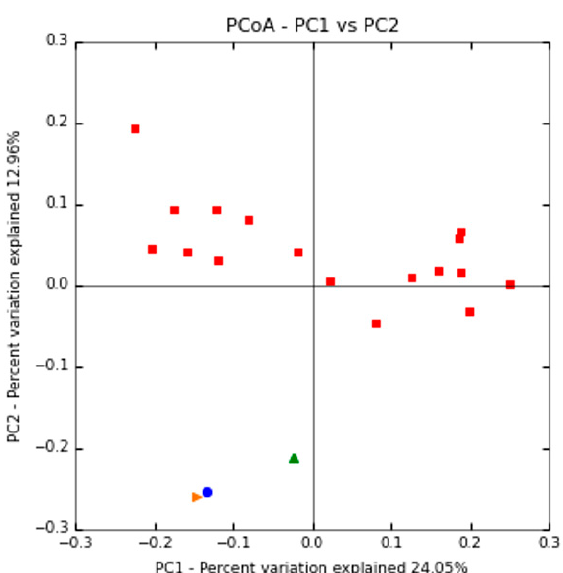
Figure 6. PCoA of beta-diversity values based on Bray Curtis distances. Patient gut microbiota at T 0 : blue circle, T 1 : orange triangle, T 2 : green triangle, and healthy controls: red squares.